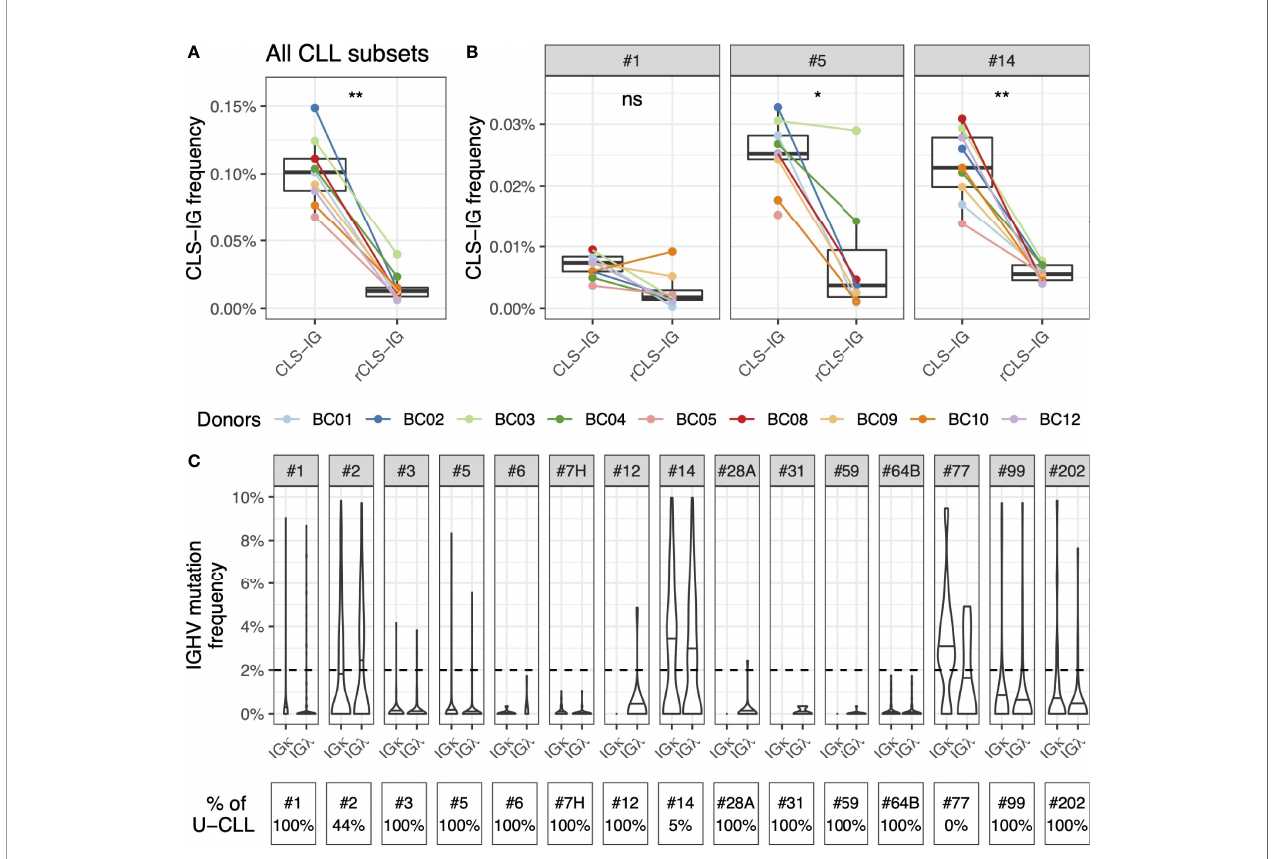
FIGURE 6 | Similar utilization of IGHV mutated and unmutated genes by CLS-IG and CLL stereotypes. (A) CLS-IG and rCLS-IG frequency in normal B cells. (B) Frequency of CLS-IG and rCLS-IG of the #1, #5 and #14 CLL subsets in normal B cells. Paired Wilcoxon test was performed, only signi fi cant statistics are shown (*p ≤ 0.05, **p ≤ 0.01; ns, not signi fi cant). (C) Mutation pattern of the IGHV genes utilized by CLS-IG from normal B cells subdivided for the indicated CLL subsets; the horizontal lines indicate the median mutation for each subset. The dotted line indicates the 2% mutation threshold separating U and M sequences. The percentage of CLL stereotypes with unmutated IGHV in each CLL subset is shown at the bottom of the fi